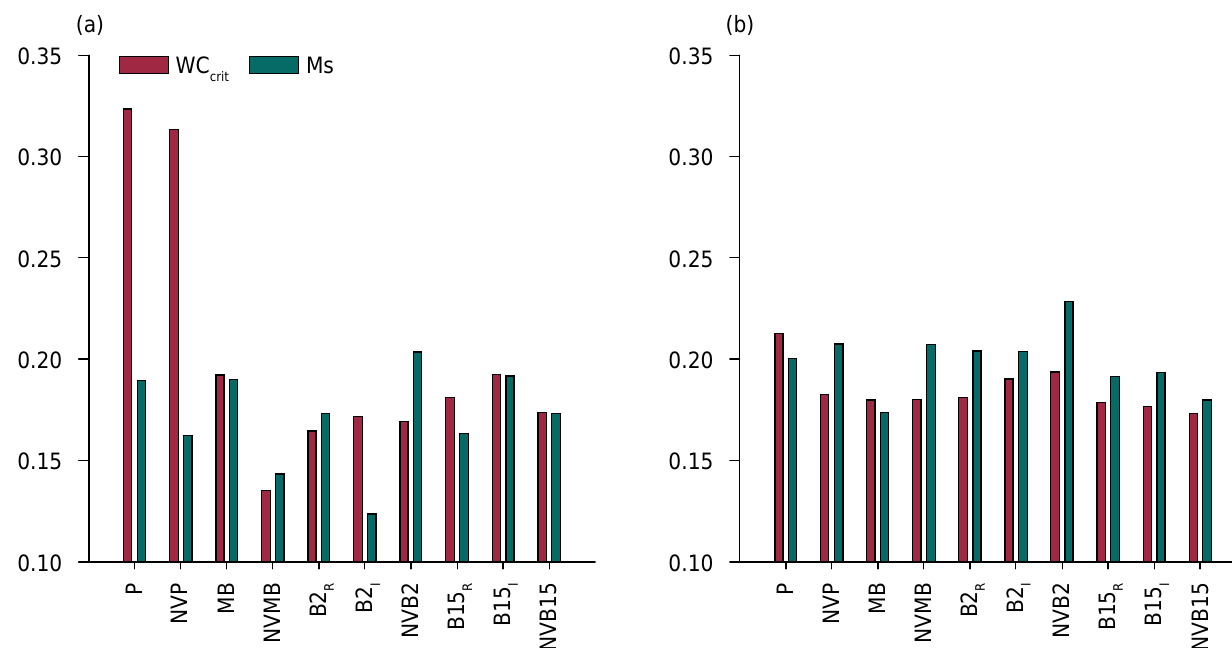
Figure 1. Mean critical water content ( WC crit ) and water content at field capacity ( Ms ) at layers of 0.00-0.10 m (a) and 0.20-0.30 m (b) for irrigated soils under pasture (P), corn and beans in succession (MB), banana (B2 and B15), and natural vegetation (NVMB, NVB2, and NVB15) in the Jaguaribe/Apodi Irrigated Area. Subscribed letters represent the crop row (R) and inter-row (I) spaces, respectively. Errors bars indicate standard error of the mean